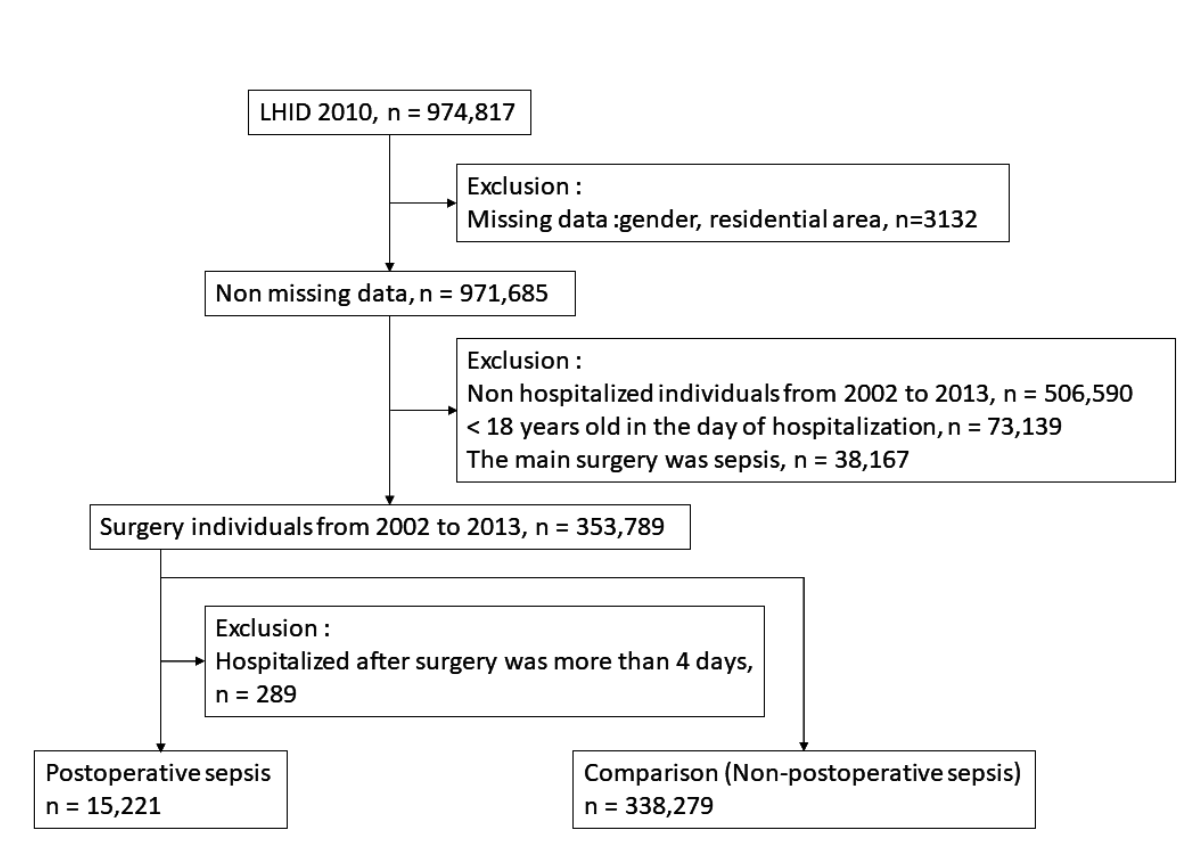
Figure 1. Case selection